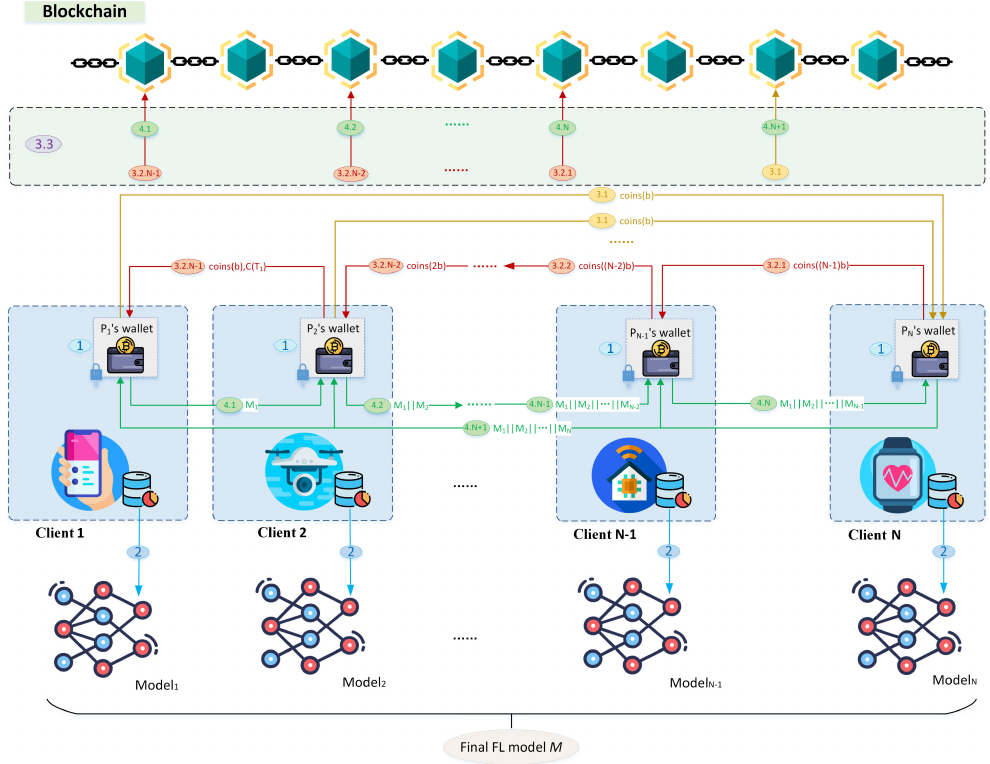
Figure 2. The work flow of